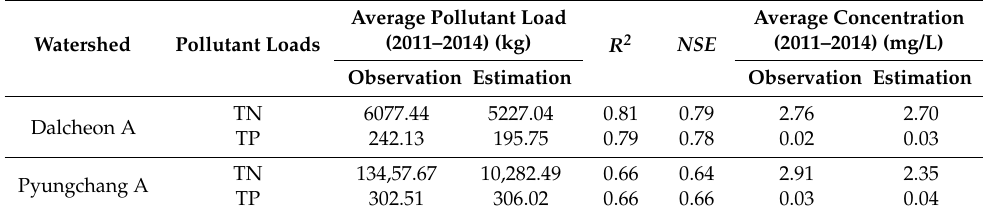
Figure 7. Comparison between simulated TN ( a ) and observed TN ( b ) at Pyungchang A watershed (2011–2014). Table 8. Comparison between estimated and observed eight-day average pollutant loads in the period between 2011 and